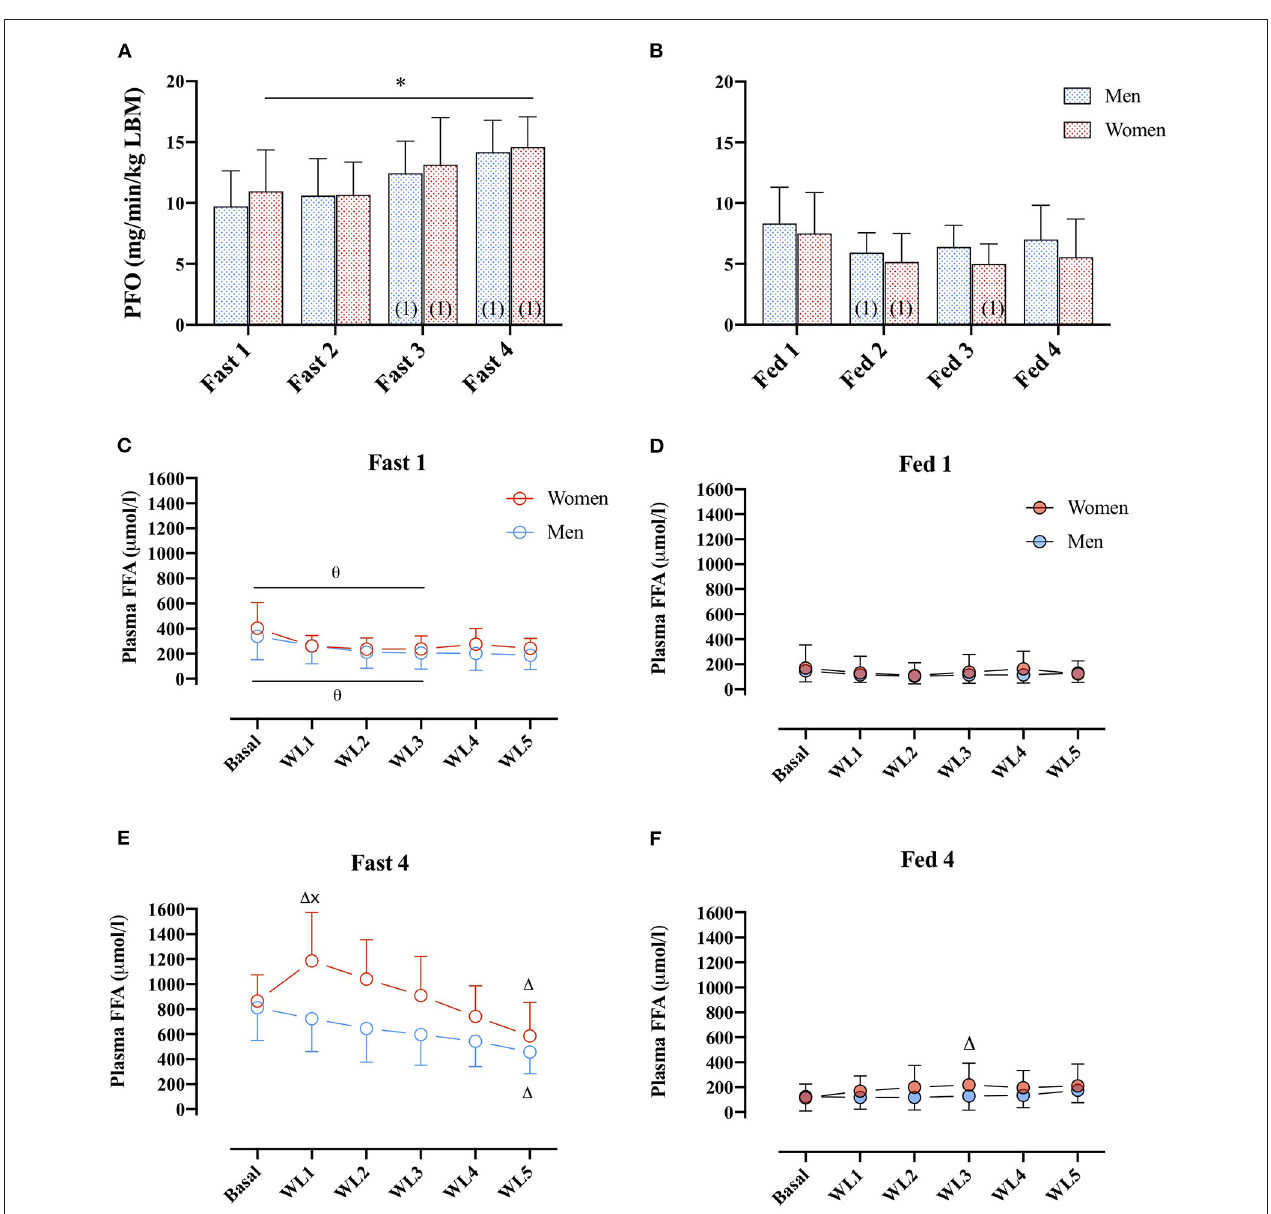
FIGURE 4 | (A) PFO (mg/min/kg FFM) during GXT Fast 1, 2, 3, and 4 in men (dashed blue bars) and women (dashed red bars). (number) represents statistical difference from GXT number. (B) PFO (ml/min/kg FFM) during GXT Fed 1, 2, 3, and 4 in men and women.* represents the significant difference between conditions within similar GXT, (1) represents the significant difference from first GXT within similar condition. (C,D) Plasma FFA concentrations ( µ mol/L) during GXT Fast 1, Fed 1, respectively, at rest (basal) and at WL 1, 2, 3, 4, and 5, representing 60, 95, 130, 165, and 200W in women and 95, 130, 165, 200, and 235W in men. (E,F) Plasma FFA concentrations ( µ mol/L) during Fast 4 and Fed 4, respectively. 1 represents the significant difference from Basal within same GXT and sex, x represents the significant difference between sex within same GXT and WL, and θ represents the significant difference between GXT within similar WL and sex. Women Fast 1: Basal, n = 11, WL1, n = 9, WL2, n = 10, WL3, n = 9, WL 4, n = 10, WL5, n = 7; Women Fast 4: basal, n = 10, WL1, n = 9, WL2, n = 10, WL3, n = 9, WL4, n = 10, WL5, n = 7. Men Fast 1: basal, n = 10, WL1, n = 9, WL2, n = 9, WL3, n = 9, WL4, n = 9, WL5, n = 9. Men Fast 4: basal, n = 10, WL1, n = 9, WL2, n = 9, WL3, n = 9, WL4, n = 9, WL5, n = 9. Data are represented as mean ± SD.